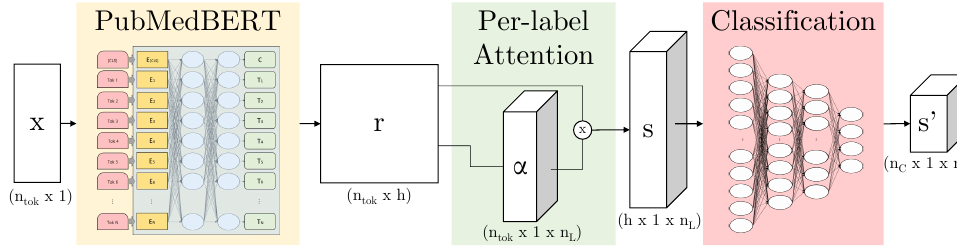
Figure 8. Our model architecture: PubMedBERT [9] maps from input x to a hidden representation r (this subarchitecture indicated in yellow can be replaced by another BERT variant); per-label attention maps to s which contains a separate representation for each label; the attention vector α can be visualised by overlaying this on the original text, again per-label; finally, the representation is passed through three classification layers to produce a per-label per-class prediction s (cid:48)